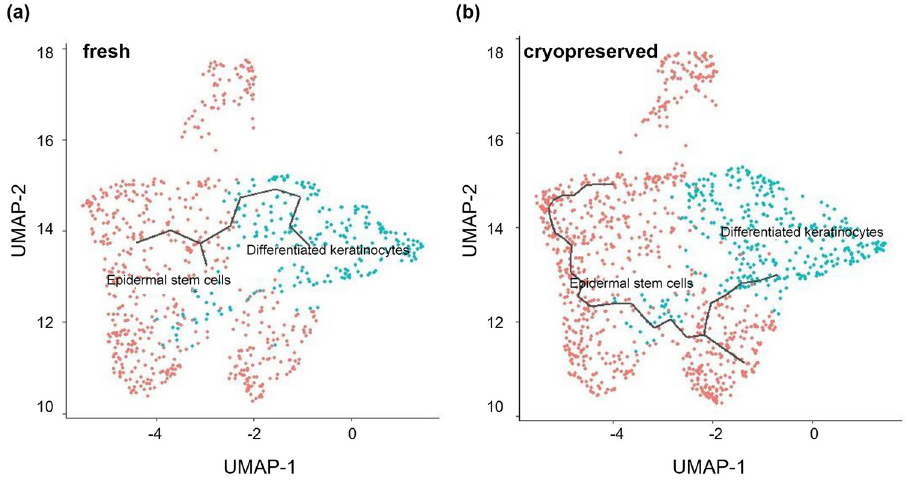
Fig 6. Single-cell trajectory analysis shows epidermal stem cells differentiate into keratinocytes in both fresh and cryopreserved